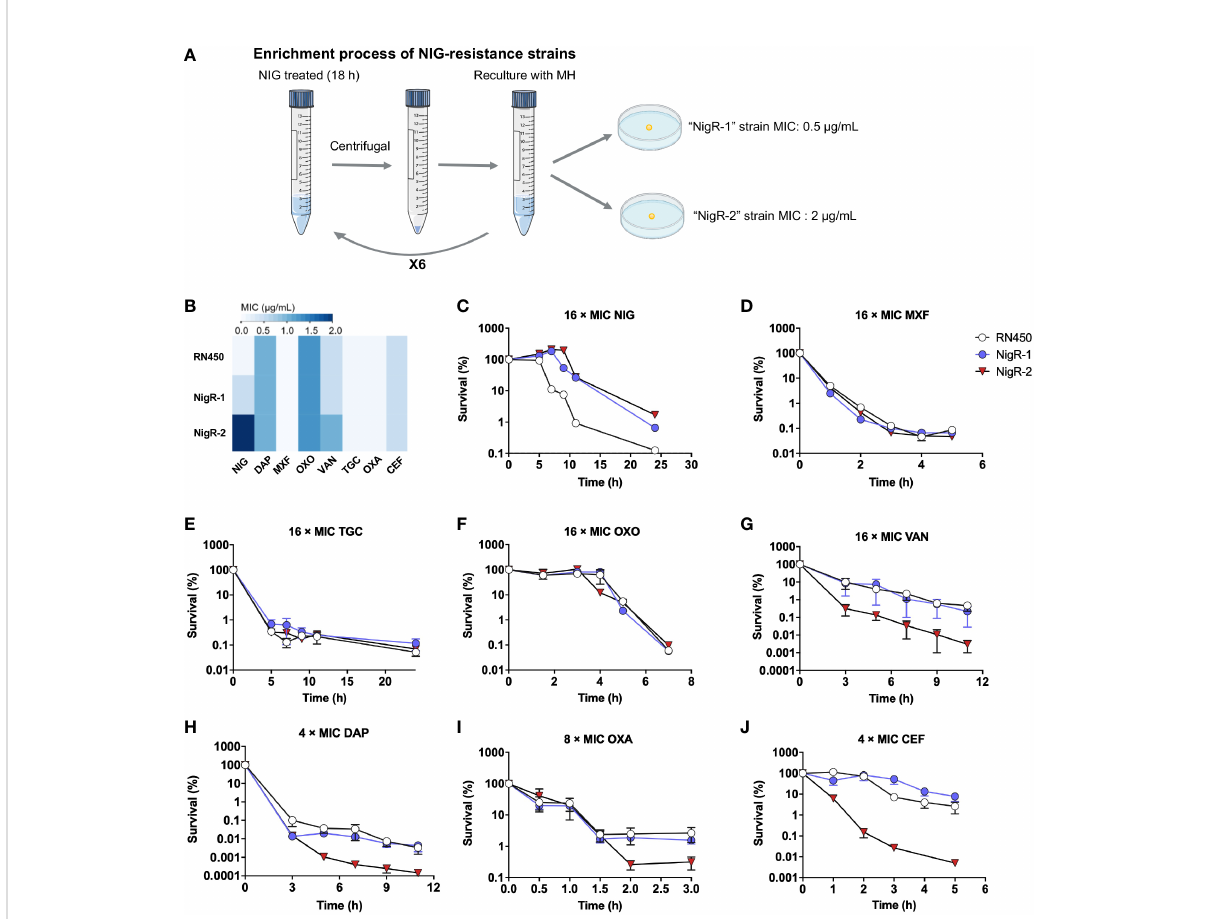
FIGURE 5 Lack of cross-resistance to other antimicrobials by S. aureus mutants acquired “ resistance ” to nigericin. (A) Schematic representation of enrichment used to obtain nigericin-resistant mutants of S. aureus strain RN450. (B) Comparison of MIC of various classes of antibiotics against RN450 and its nigericin-resistance mutant strains. (C – J) Effect of nigericin resistance mutations on killing by nigericin (NIG, C ), moxi fl oxacin (MOX, D ), tigecycline (TGC, E ), oxolinic acid (OXO, F ), vancomycin (VAN, G ), daptomycin (DAP, H ), oxacillin (OXA, I ), and cefoxitin (CEF, J ) for the indicated times and concentrations. Data are average of 3 biological replicates; error bars indicate